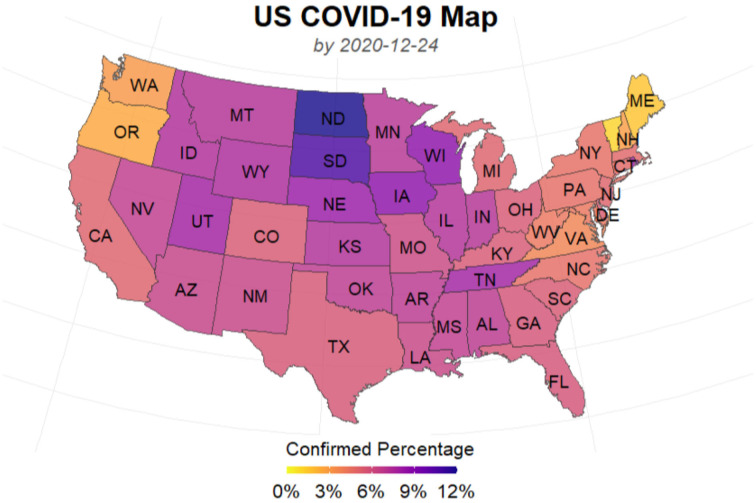
U.S. COVID-19 map.